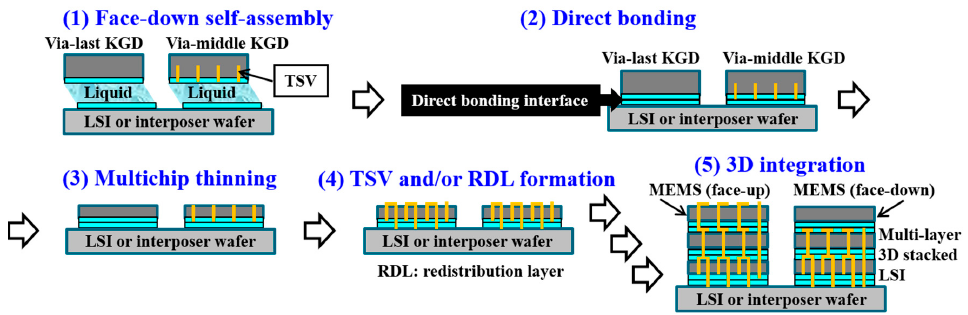
Figure 1. Typical non-transfer stacking based heterogeneous 3D system integration using MCtW self-assembly and thermocompression direct bonding.